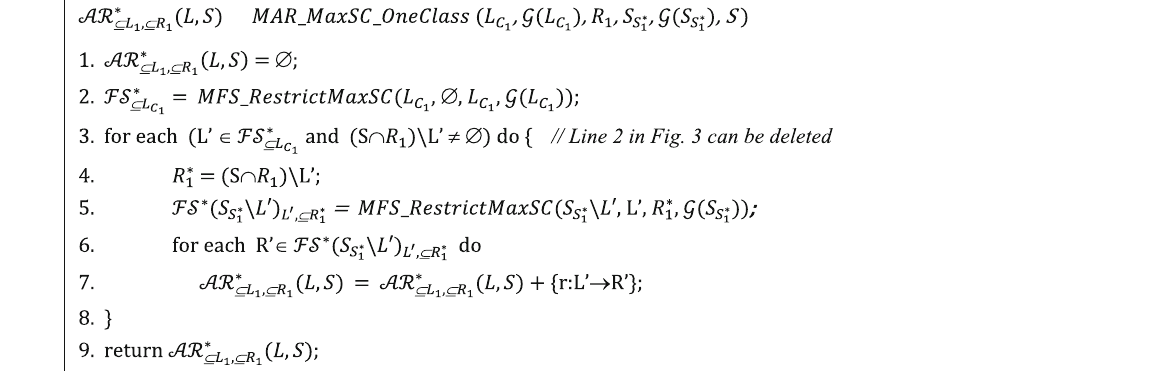
Fig. 4 The M AR _ MaxSC _ OneClass